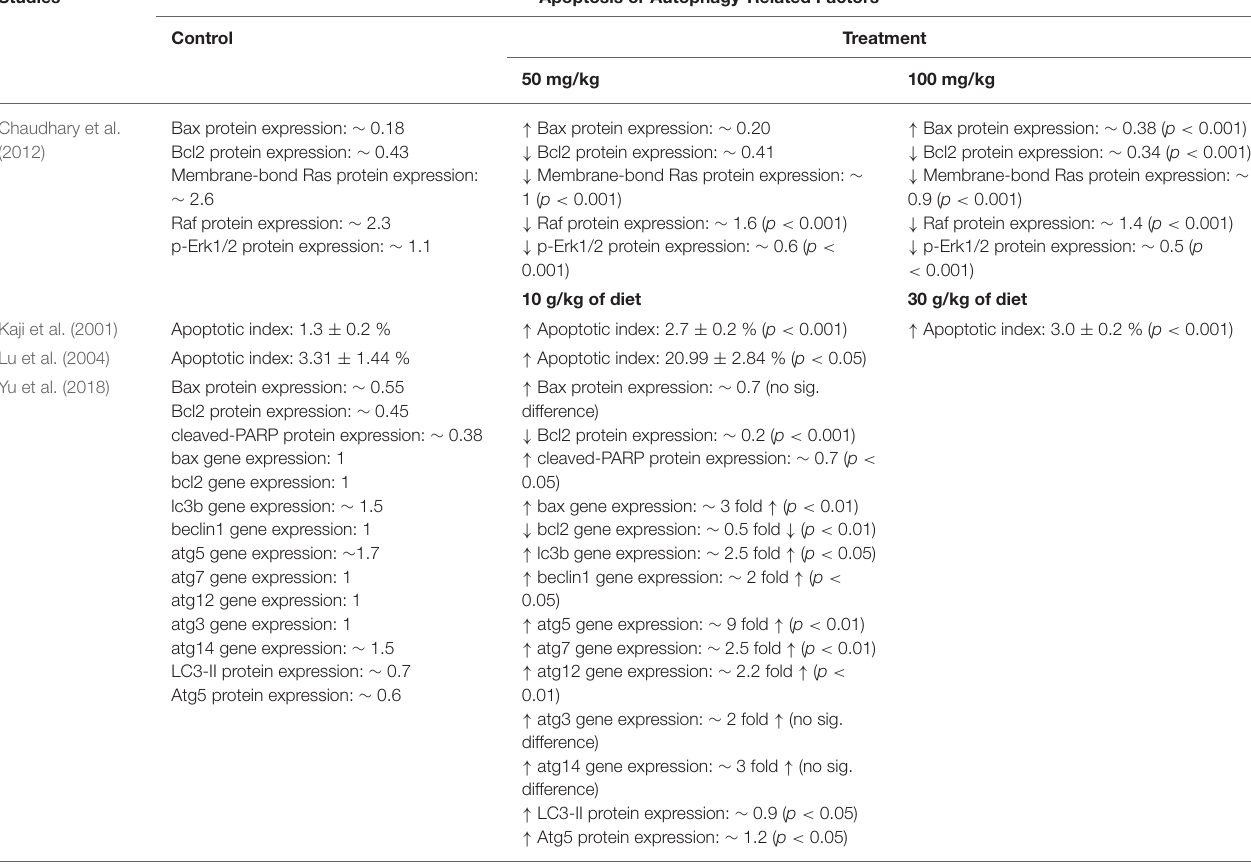
TABLE 4 | Effects of limonene intervention on apoptotic/autophagy-related factors. Studies